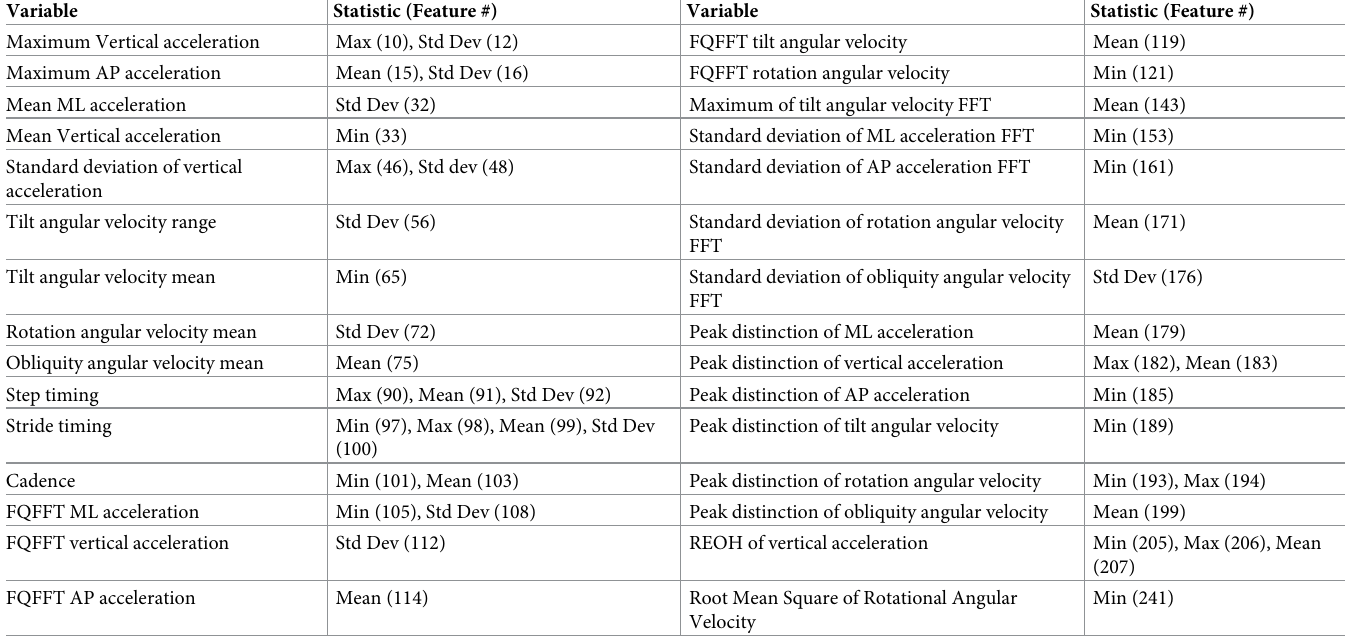
Table 1. Legend of feature descriptions for feature sets in Table